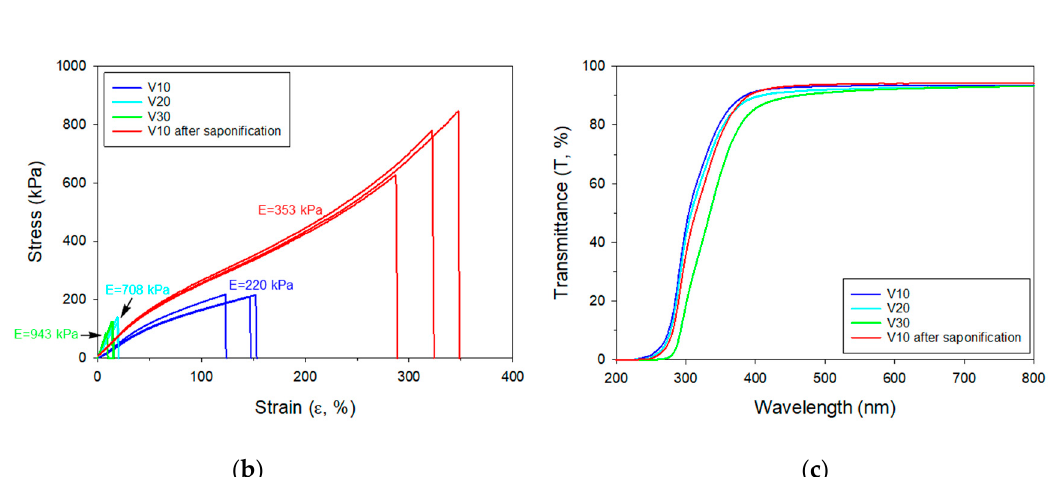
Figure 1. IR spectra of VPDMS and the films UV-cured from the V10 and V30 solution layers ( a ). Stress–strain curves ( b ) and transmittance spectra ( c ) of the films UV-cured from the V10, V20, and V30 solution layers and of the film UV-cured from the V10 solution layer after saponification, respectively.